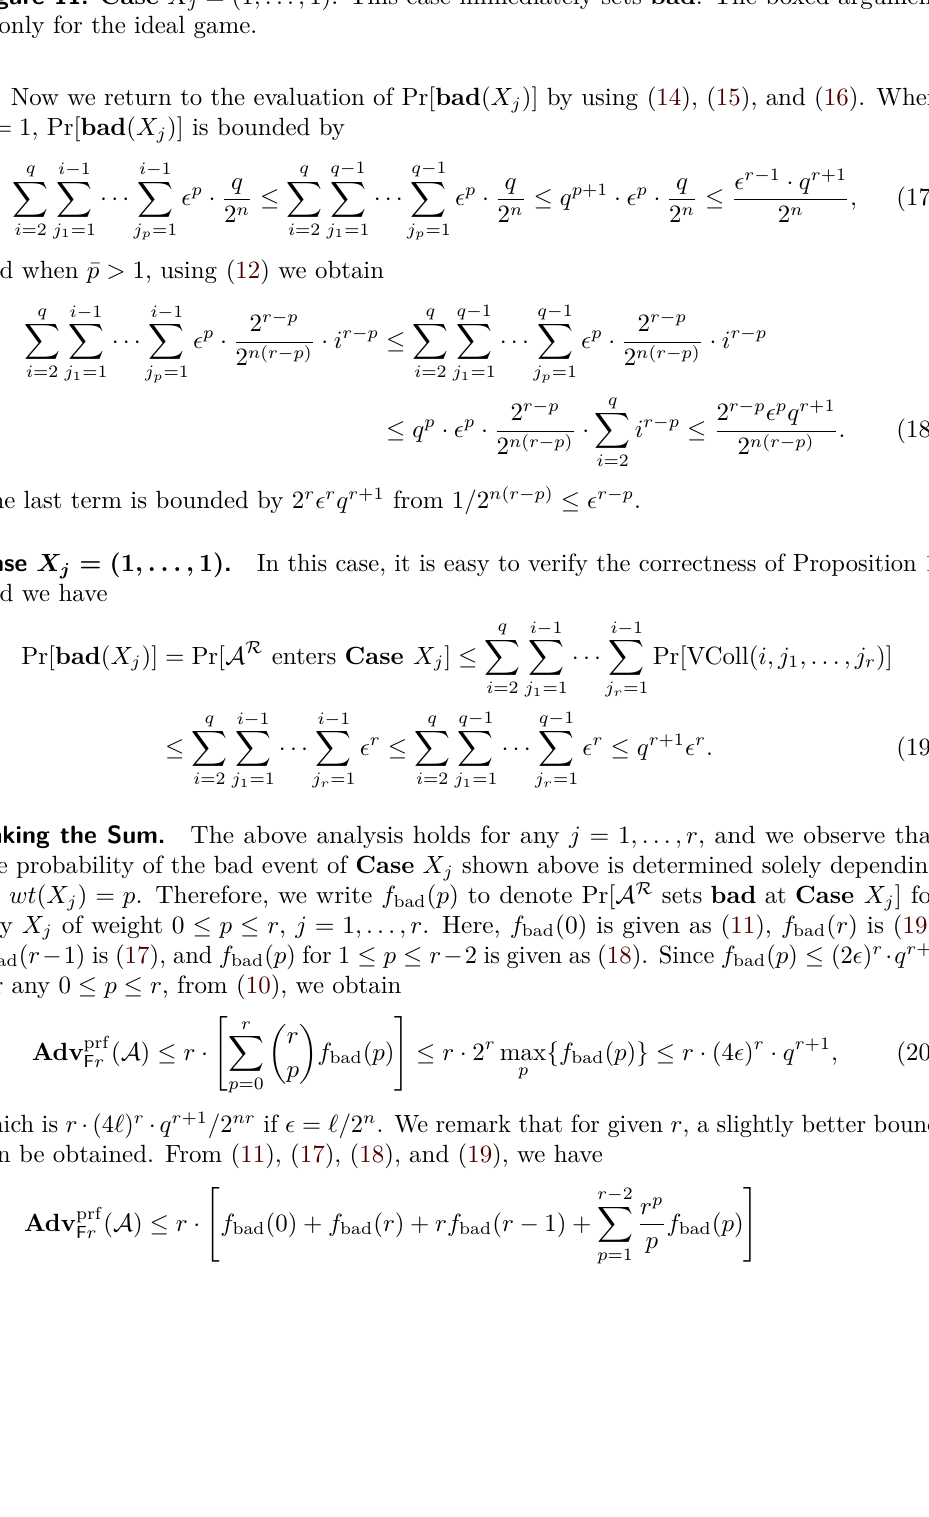
Figure 11: Case X j = (1 , . . . , 1). This case immediately sets bad . The boxed argument is only for the ideal